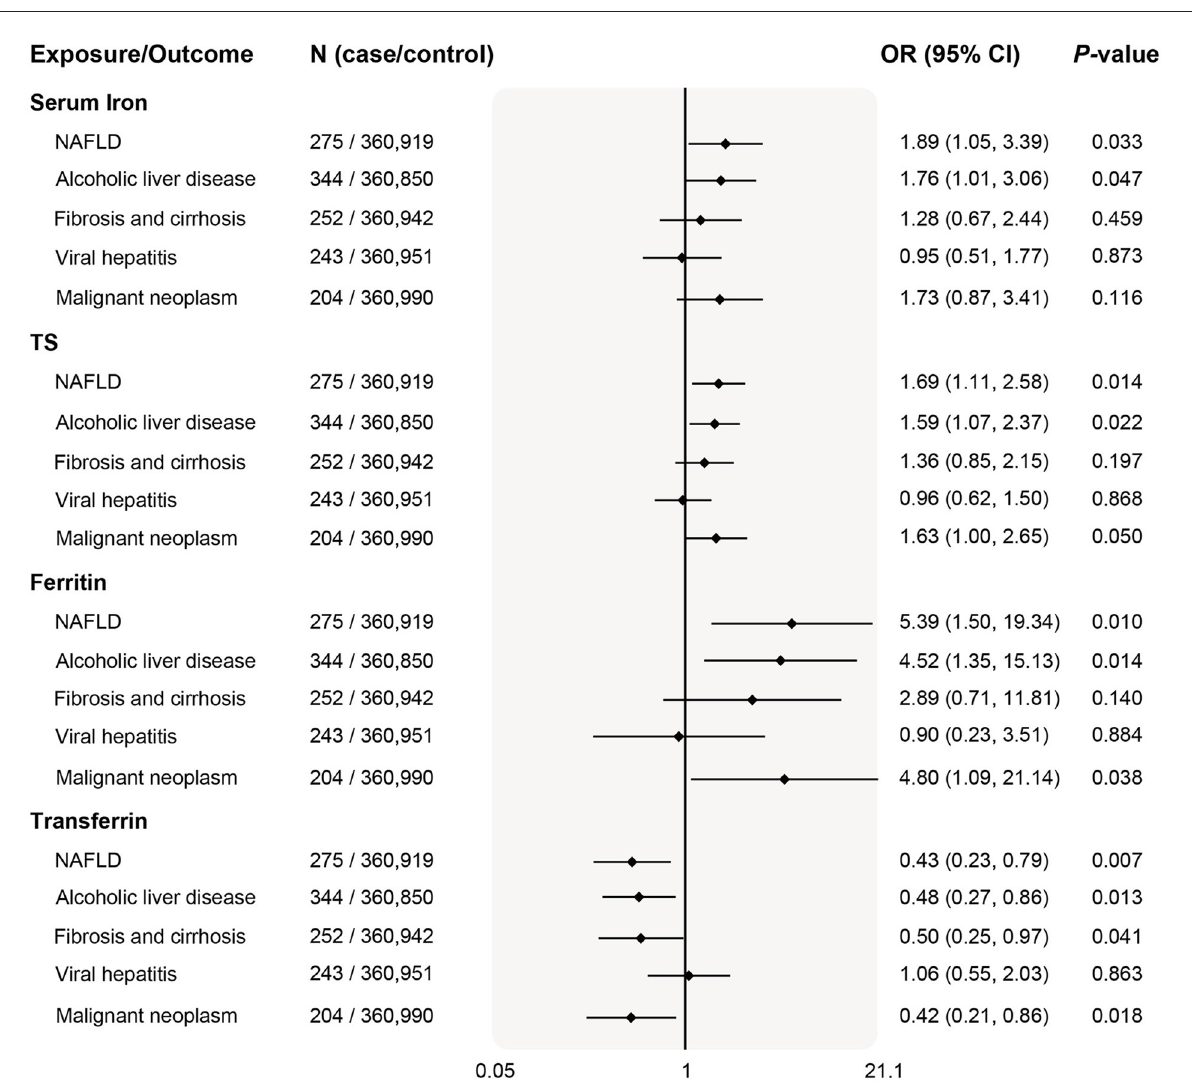
NAFLD risk, odds ratios estimation of per SD increase in biomarker levels were 1.19 (95% CI 1.07–1.31, P = 5.3 × 10 for serum iron, 1.15 (95% CI 1.06–1.24, P = 2.3 × 10 transferrin saturation, 1.57 (95% CI 1.29–1.85, P = 1.7 × 10 for ferritin, and 0.8 (95% CI 0.66–0.94, P = 1.9 × 10 serum transferrin (Figure 5). The positive association between iron status and NAFLD risk was also replicated in both weighted median and MR-Egger estimations (Supplementary Table 9).